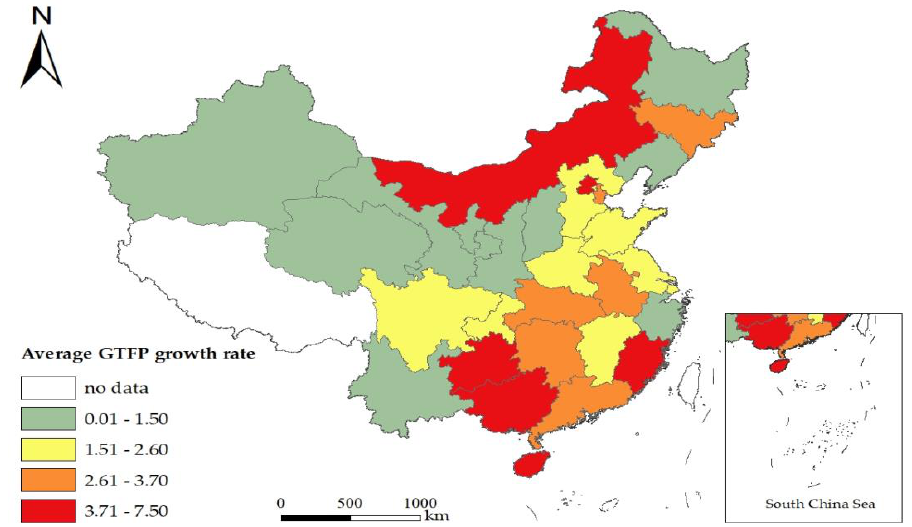
Figure 4. Spatial distribution of regional average GTFP growth rate in China from 2003 to 2017.